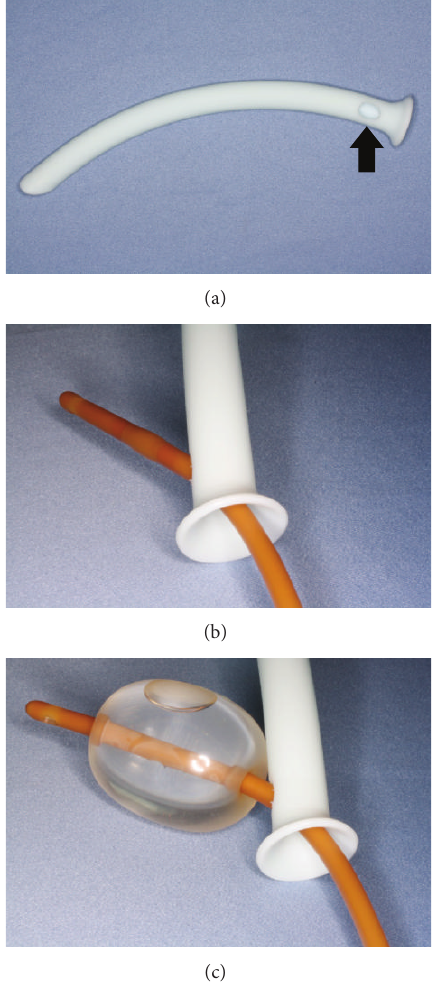
Figure 2: Nasal airway and balloon catheter devices are assembled through the window of the nasal airway (a, b, and c).